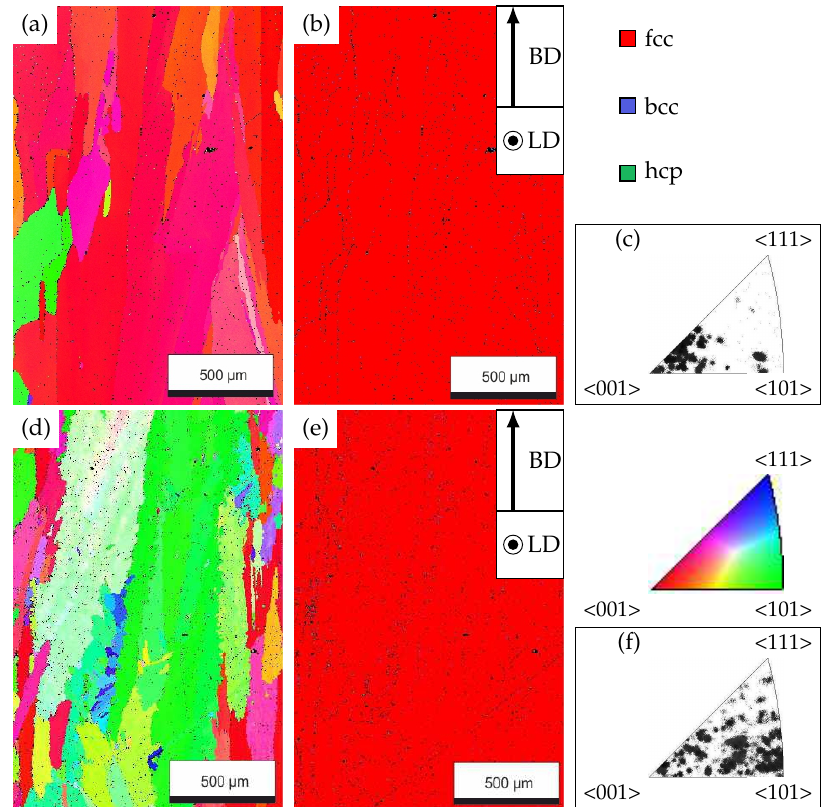
Figure 5. Inverse pole figure mappings (IPFM), phase mappings (PM), and inverse pole figures (IPF) of ( a – c ) pure AISI316L and ( d – f ) pure CoCrMo zones. Grain orientations are plotted with respect to